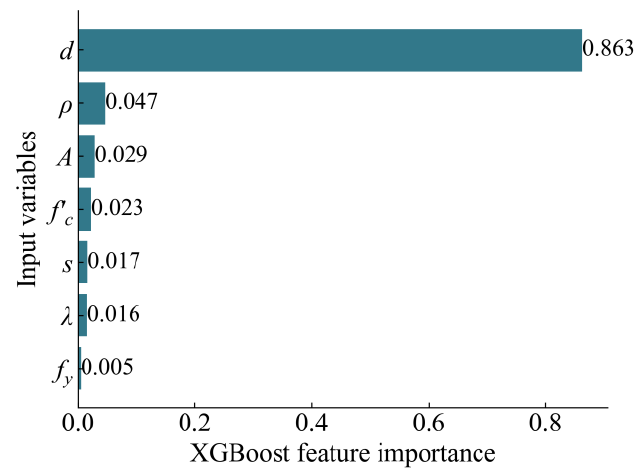
Figure 6. Importance sorting using XGBoost feature importance.